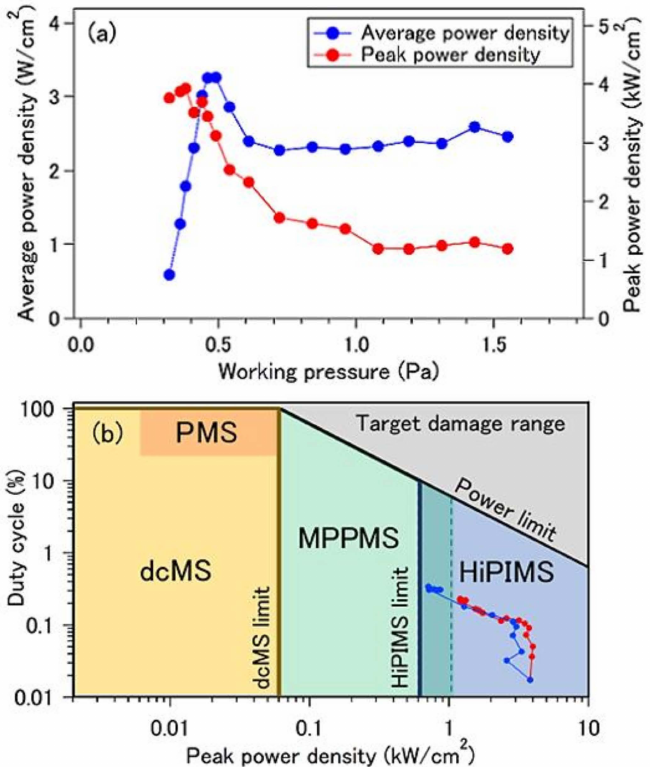
Figure 10. ( a ) Average power density (blue solid circles) and peak power density (red solid circles) and ( b ) classification for discharge characteristics in magnetron sputtering in MPPMS for a working pressure in the range of 0.32 to 1.55 Pa. The duty cycle is plotted with respect to the peak power density at the target. The red solid circles and blue circles show the data corresponding to the full power waveforms and the partial power waveforms, except for the first pulse, in Figure 3a,b,